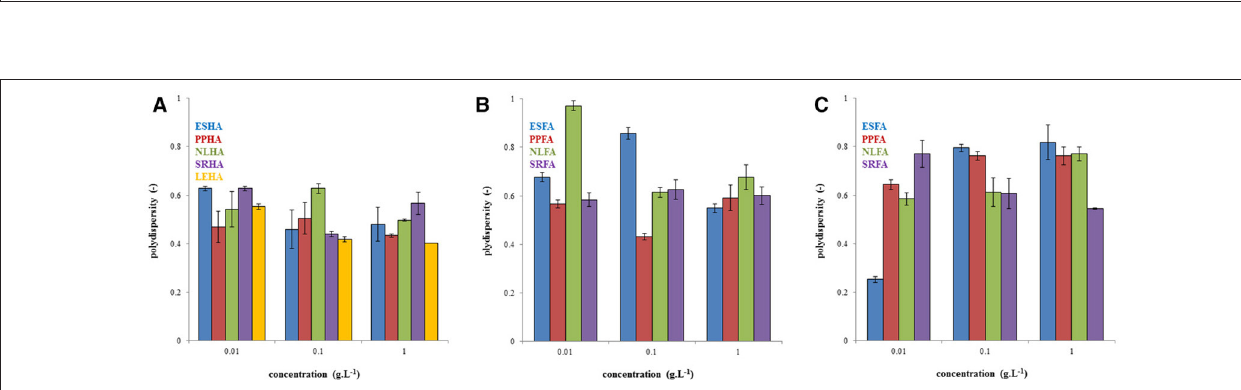
FIGURE 1 | Average diameters of humic acids in 0.01M NaOH (A) , fulvic acids in 0.01M NaOH (B) and in water (C) determined on the basis of the intensity particle size distribution.